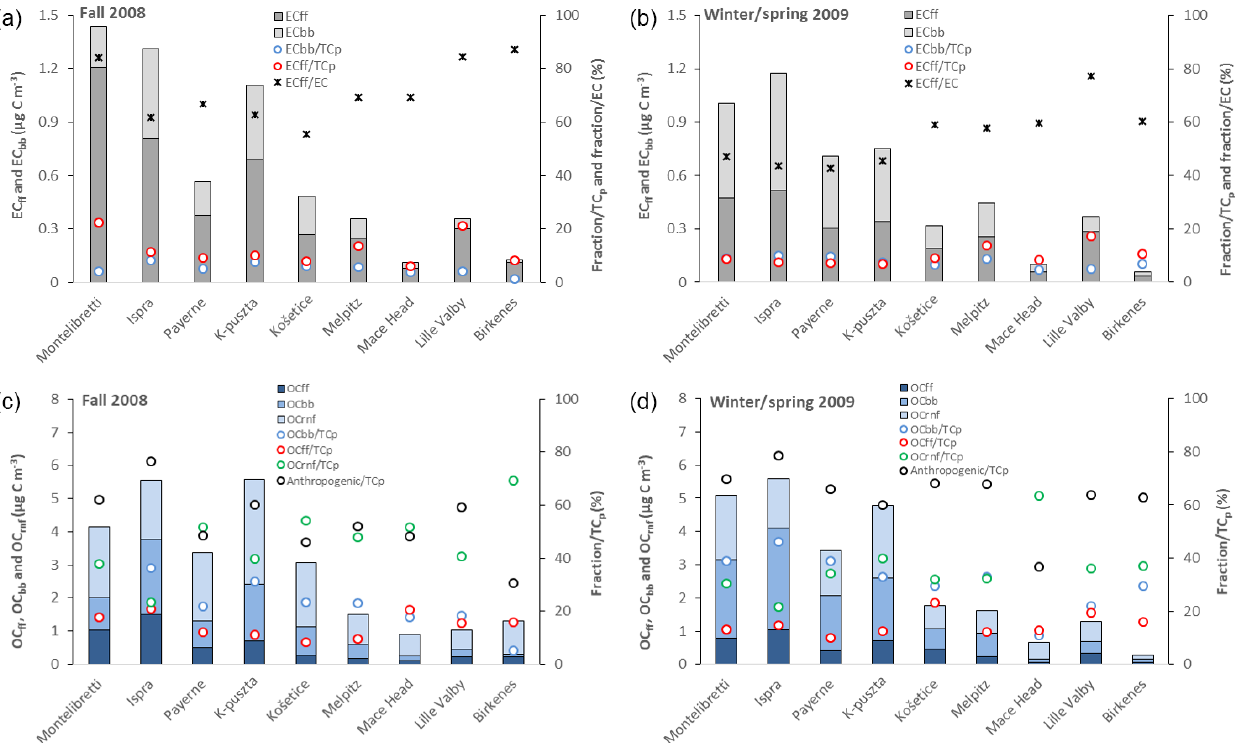
Figure 2. Mass concentrations of EC from fossil-fuel (EC ff ) and biomass burning (EC bb ) sources, their fraction of particulate total carbon (TC p ), and the fraction of EC ff to EC for fall 2008 (a) and winter/spring 2009 (b) . Mass concentrations of OC from fossil-fuel (OC ff ), biomass burning (OC bb ), and remaining non-fossil (OC rnf ) sources, their fraction of TC p , and the fraction of anthropogenic (OC ff , OC bb , EC ff , and EC bb ) to TC p for fall 2008 (c) and winter/spring 2009 (d) . The sites are listed by latitude from south to north. Note that the EC ff / TC p marker is superimposed on the EC bb / TC p marker for Montelibretti and K-puszta in (b) , and that the OC ff / TC p marker is superimposed on the OC bb / TC p marker for Montelibretti in (c) . Table 4. Model and source-apportioned (LHS-derived) concentrations of elemental carbon (EC bb ) and organic carbon (OC bb ) from biomass burning. Model results are averages over both measurement periods (fall 2008 and winter/spring 2009). For the LHS results the means of the 10th and 90th percentiles are shown. Unit: µgCm − 3 . EC bb OC